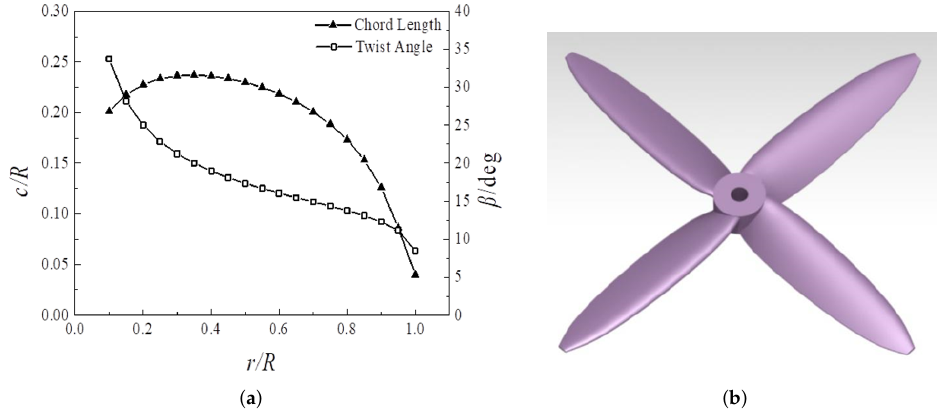
Figure 9. Tested propeller. ( a ) Chord and twist angle of tested propeller; ( b ) Sketch of tested propeller. The static test was conducted at an altitude of about 400 m and velocity of 0 m/s. The